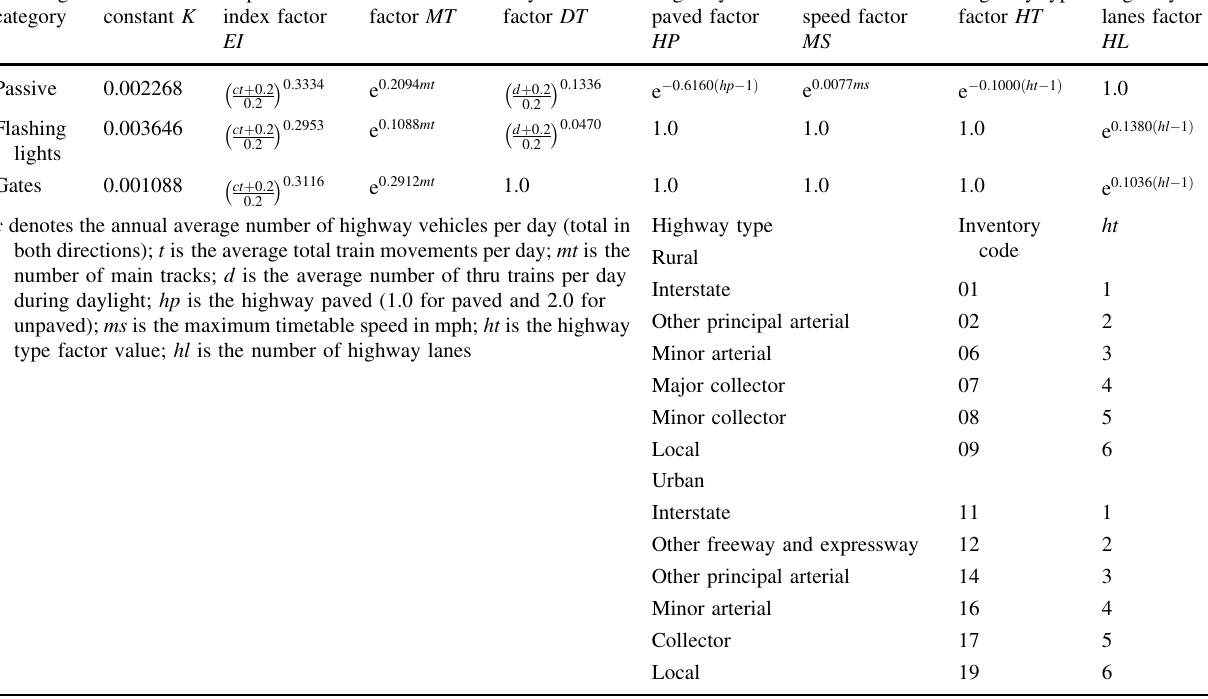
Table 5 Highway–rail grade crossing characteristic factors for the Initial US DOT Accident Prediction Formula Crossing category